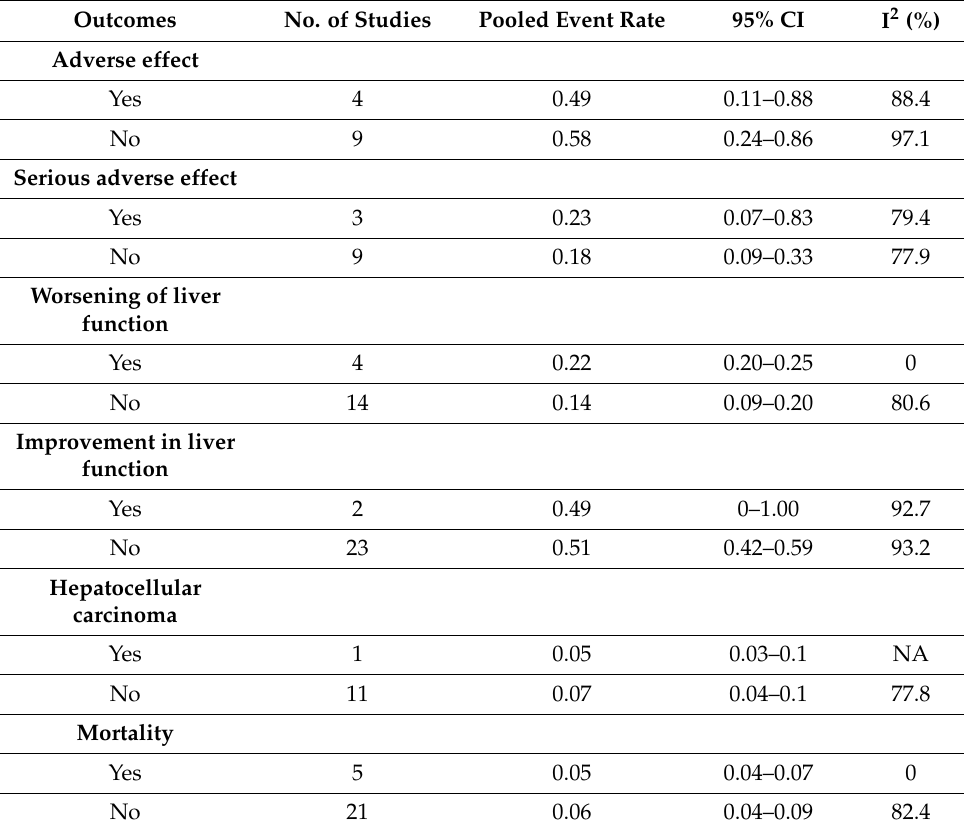
Table 4. Summary of the estimated event rate in decompensated cirrhosis patients with chronic hepatitis C virus (HCV) infection depending on the use of protease-inhibitor-containing regimen.